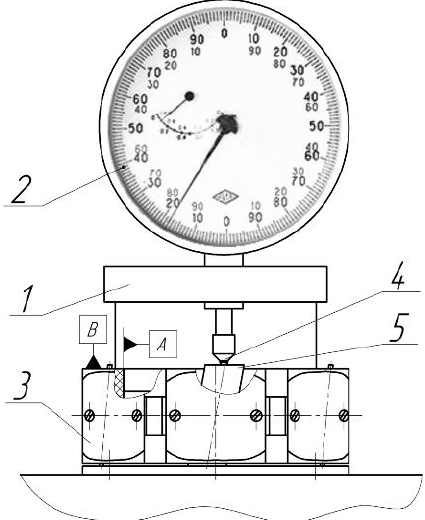
Figure 2. Device for measuring the amount of material removal: 1—case; 2—indicator head; 3— fixture; 4—tip; 5—package of plates.